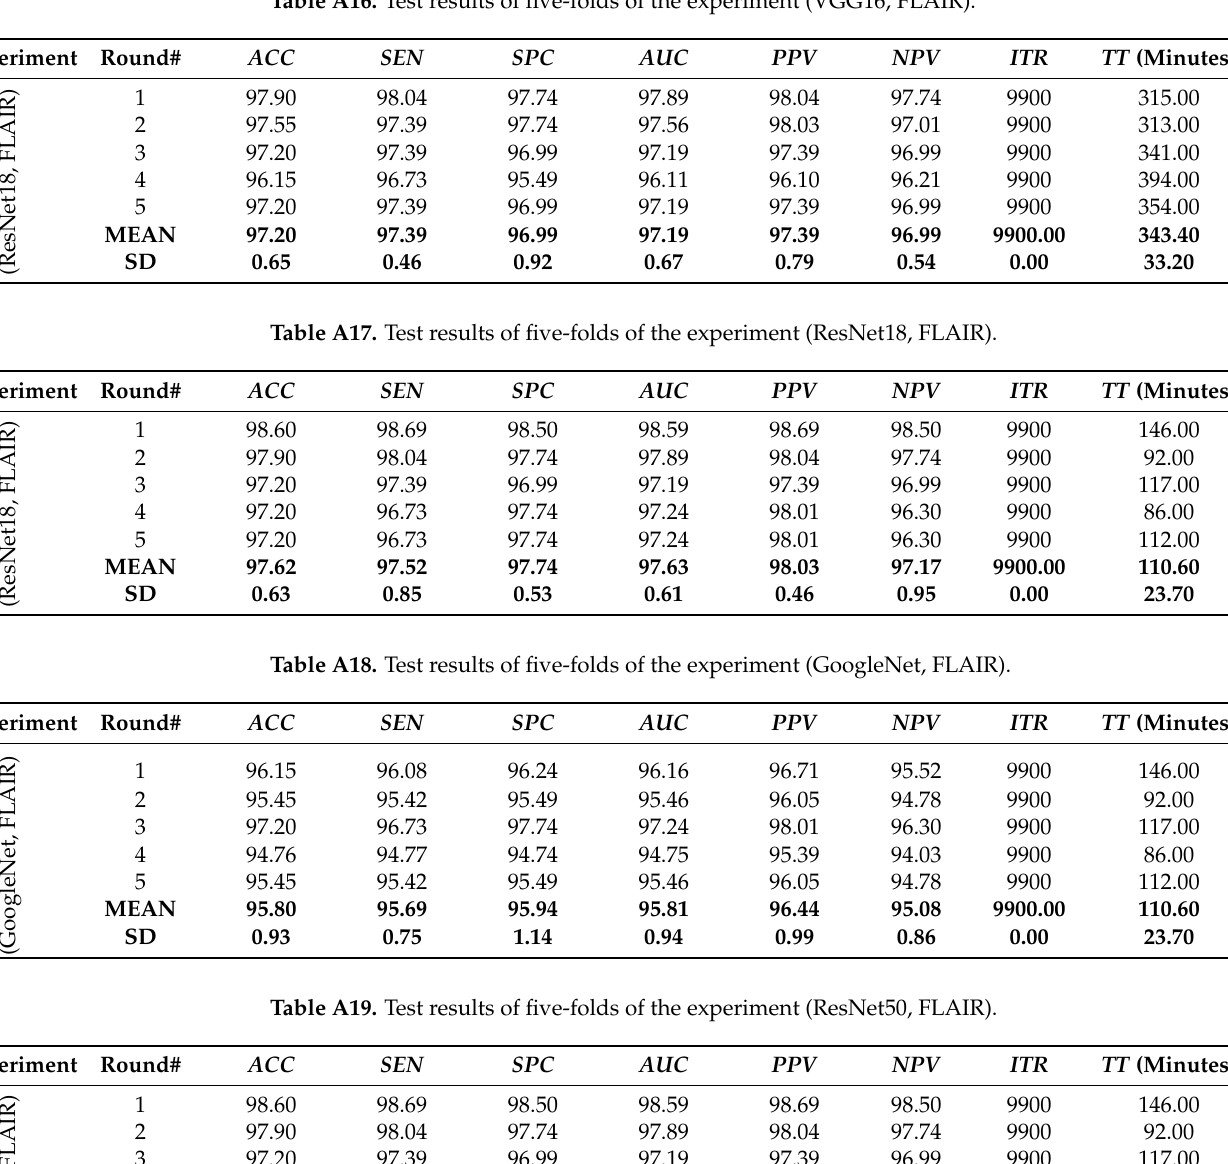
Table A16. Test results of five-folds of the experiment (VGG16, FLAIR).